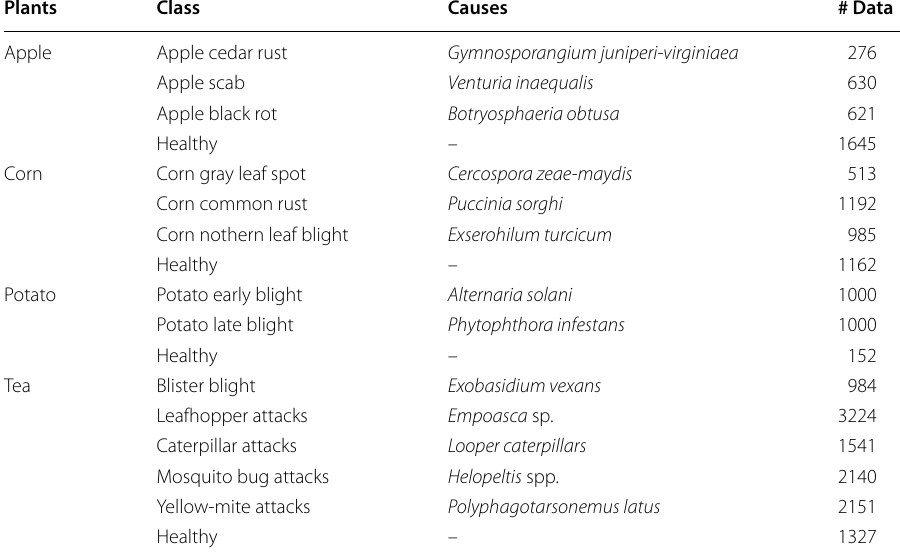
Table 2 List of plants and class labels used in the experiments with the number of data for each